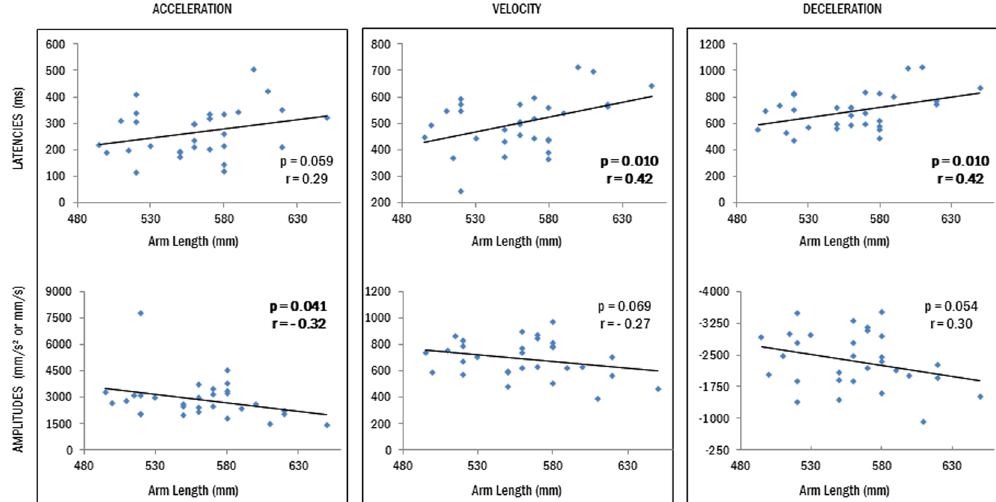
Figure 5. Correlation between kinematic parameters (peak latencies and amplitudes) and participants’ arm length. The graphs show the time at which each subject reached a particular peak (upper panels) and the amplitude of the peak (bottom panels) from the pre tool use session, plotted against the participants’ arm length. Each dot represents a subject (N = 30). Significant correlations are indicated in bold. The longer the participants’ arms, the longer their latencies and the lower the peaks